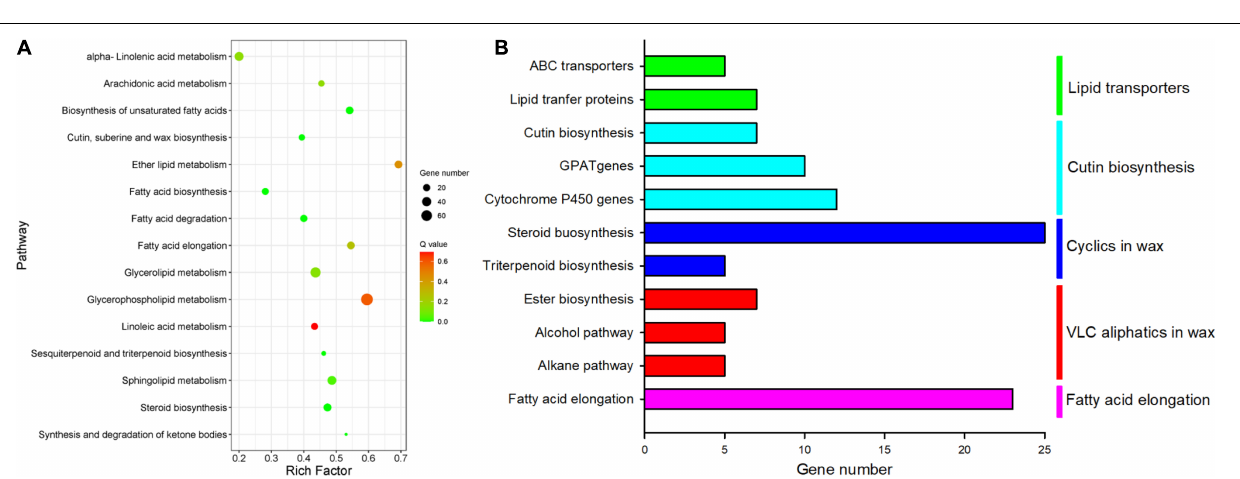
FIGURE 6 | Changes in the components of triterpenoids in wax mixtures of banana fruit cuticle stored under 4 ◦ C (low temperature, LT) and 25 ◦ C (room temperature, RT) at 6 days. Data are given as mean ± SD ( n = 5). Letters indicate the significant differences at the 0.05 level.